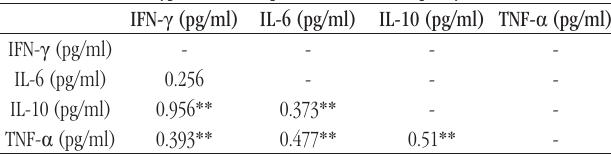
taBLE 3 − Correlation among inflammatory cytokines in type 1 diabetes patients with retinopathy